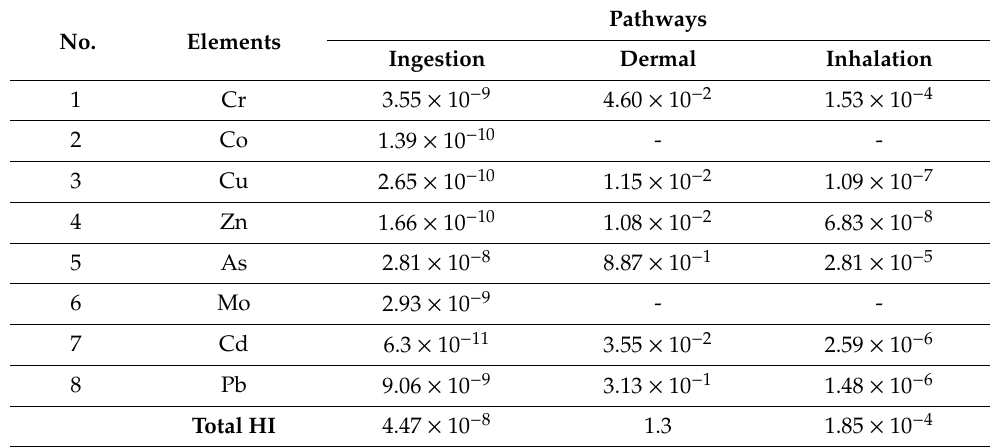
Table 10. Results of the hazard index for